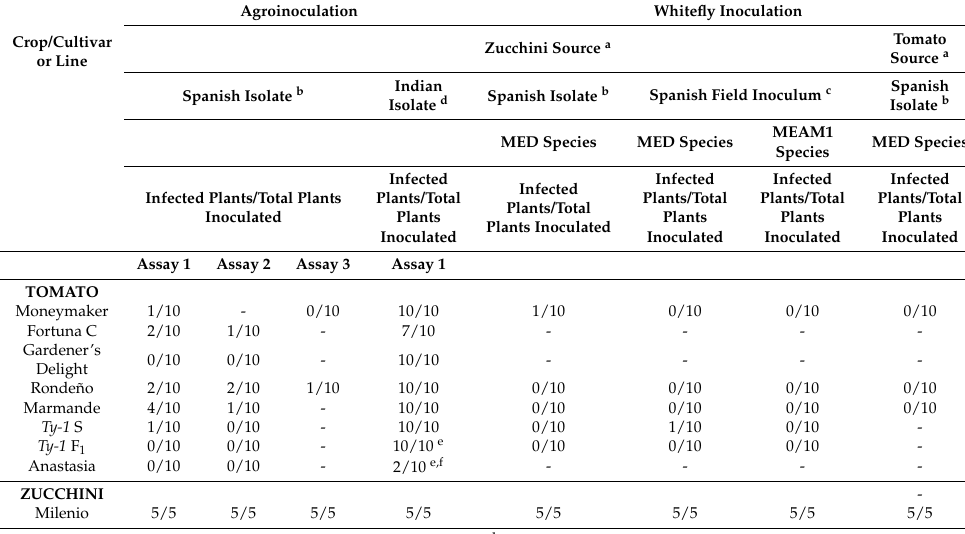
Table 4. Infectivity in plants of different cultivars/genotypes of tomato of the Spanish isolate [ES-Alm-661-Sq-13] of ToLCNDV or a field-collected ToLCNDV isolate inoculated by Agrobacterium tumefaciens -mediated and/or Bemisia tabaci -mediated (Mediterranean, MED, and Middle East–Asia Minor 1, MEAM1, species used) inoculation. The Indian isolate ToLCNDV-[IN-ND-Svr-92] was included as a control in agroinoculation experiments, and zucchini squash plants were included as a susceptible control. Inoculated plants were analyzed at 28 days post-inoculation for the presence of viruses in newly-emerged young leaves by squash blot